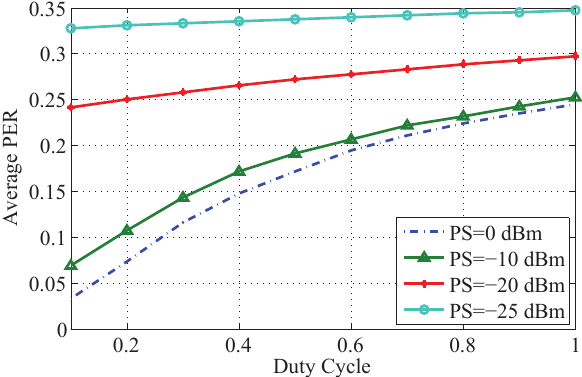
Figure 4. Average PER for different transmission power, where PS represents the transmission